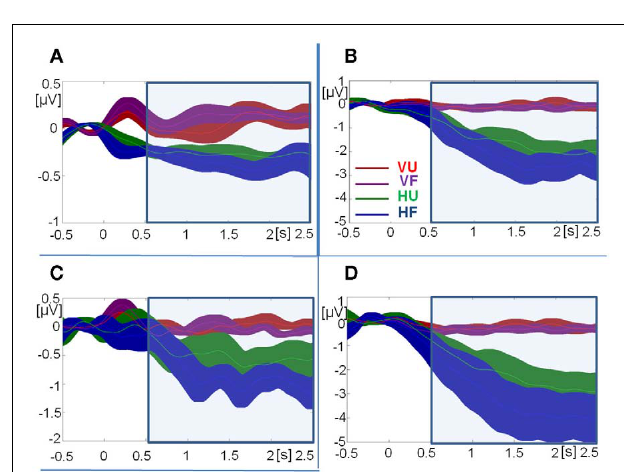
FIGURE 7 |Time courses of grand-mean total activity. (A) Theta-band activity at fronto-central sites. (B) Upper alpha-band activity at central occipital sites. (C) Upper alpha-band activity at left occipital sites. (D) Upper alpha-band activity at right occipital sites. Note: different scales for theta-band (A) and upper alpha-band activity (B–D) . Error bars indicate SE of the mean at every time-sample.VU, visual unfamiliar;VF, visual familiar; HU, haptic unfamiliar; HF, haptic familiar.The blue square indicates the analysis window.